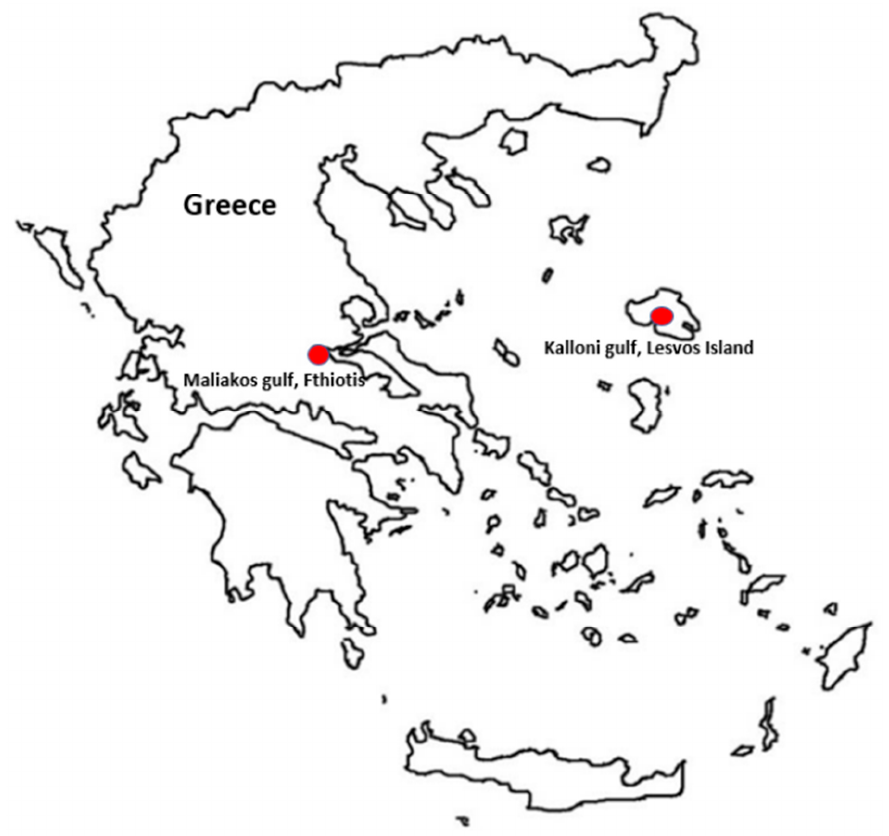
Figure 1. Sampling sites of P. nobilis specimens from Kalloni gulf, Lesvos Island (39.095818, 26.149199) and Maliakos gulf, Fthiotis (38.805781, 22.613020), within the Aegean